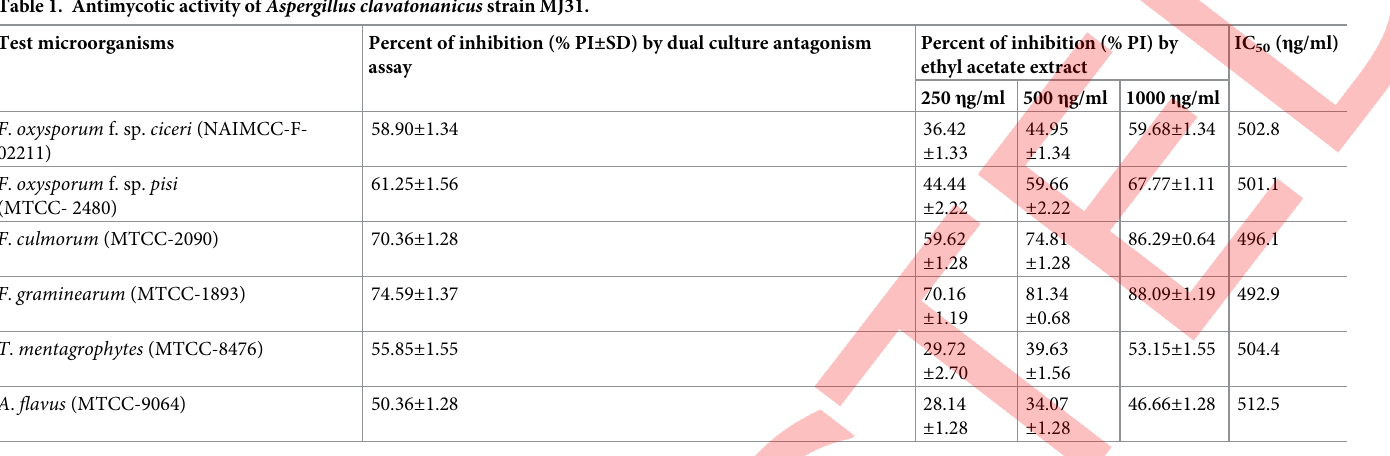
Table 1. Antimycotic activity of Aspergillus clavatonanicus strain MJ31. Test microorganisms